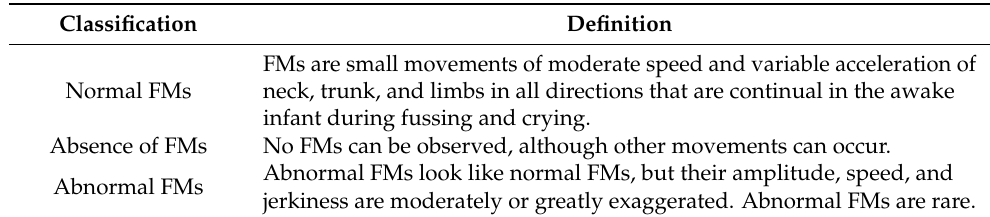
Table 2. Classification and definition of normal and aberrant